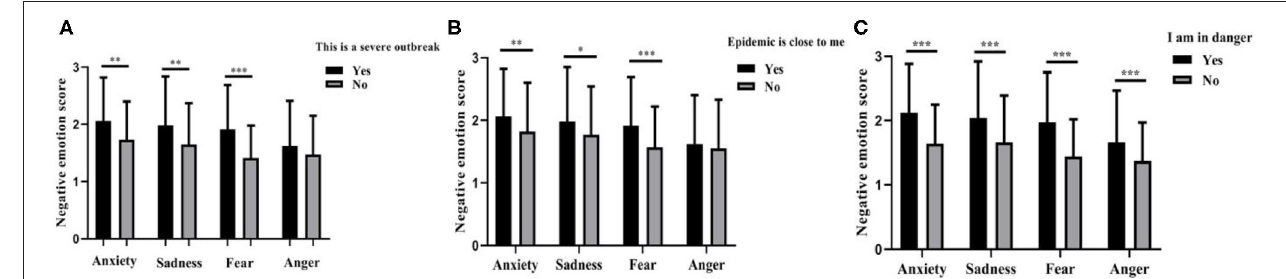
FIGURE 3 | The impact of risk perception on negative emotions. (A) This is a severe outbreak. (B) The epidemic is close to me. (C) I am in danger. * p < 0.05, ** p < 0.01, *** p < 0.001.